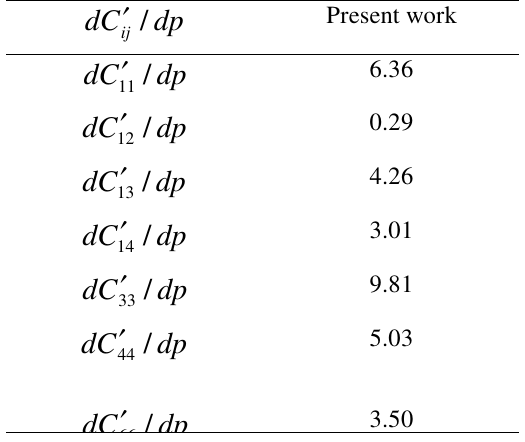
Table 5. Pressure derivatives of the second order elastic constants of LiNbO